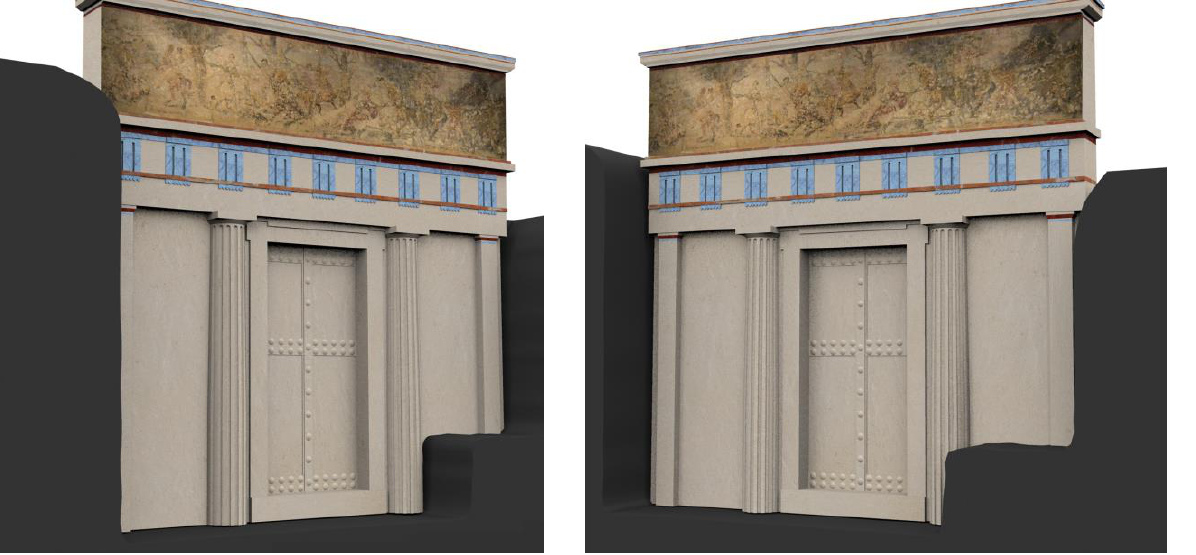
Figure 25. The Tomb of Philip II in Verghina. View from the west. Detail of the 3D model.